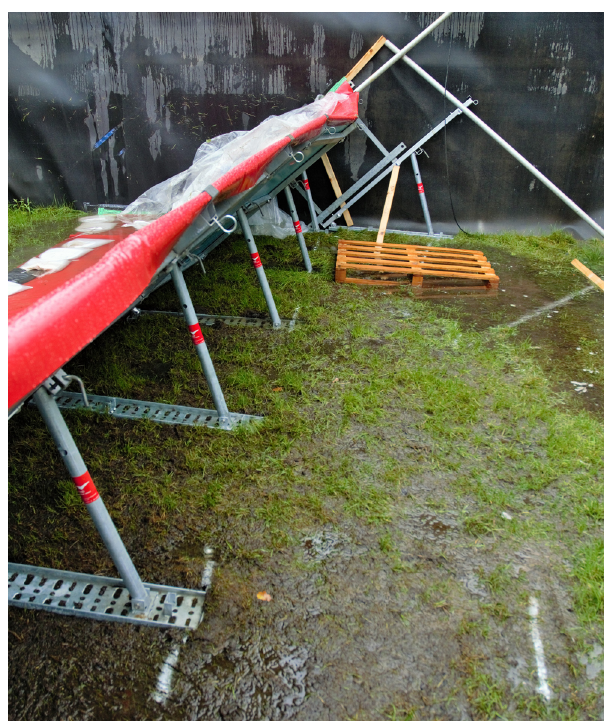
Figure 10. Supporting columns sunk into the saturated foundation soil after damming (aqua